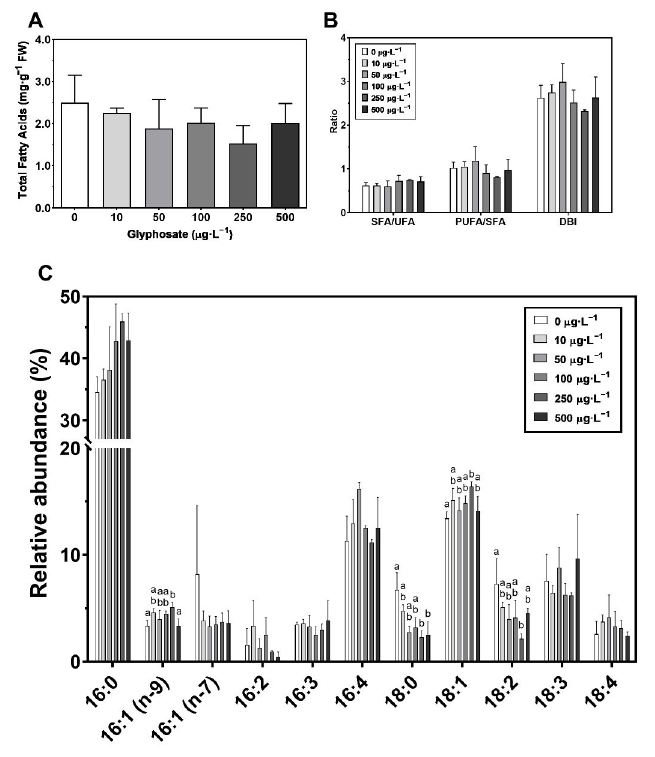
Figure 7. Total fatty acid content: ( A ) fatty acid ratios (saturated to unsaturated fatty acids ratio [SFA/UFA], polyunsaturated to saturated fatty acids ratio [PUFA/SFA] and double-bound index [DBI]); ( B ) and fatty acid relative abundance profile (%); ( C ) in Ulva lactuca following a 48-h exposure to a glyphosate-based herbicide formulation in different concentrations (mean ± s.d., n = 3, different letters indicate significant differences at p <